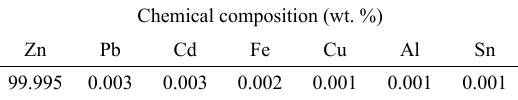
Table 2. Chemical composition of zinc ingot Chemical composition (wt. %)